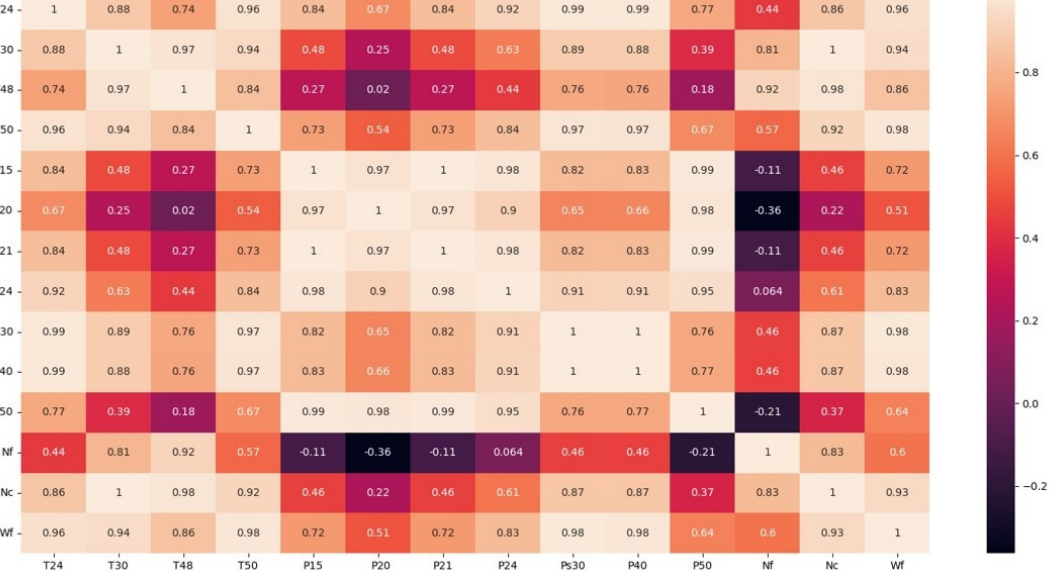
Figure 4. Performance parameters correlation matrix (DS08a).